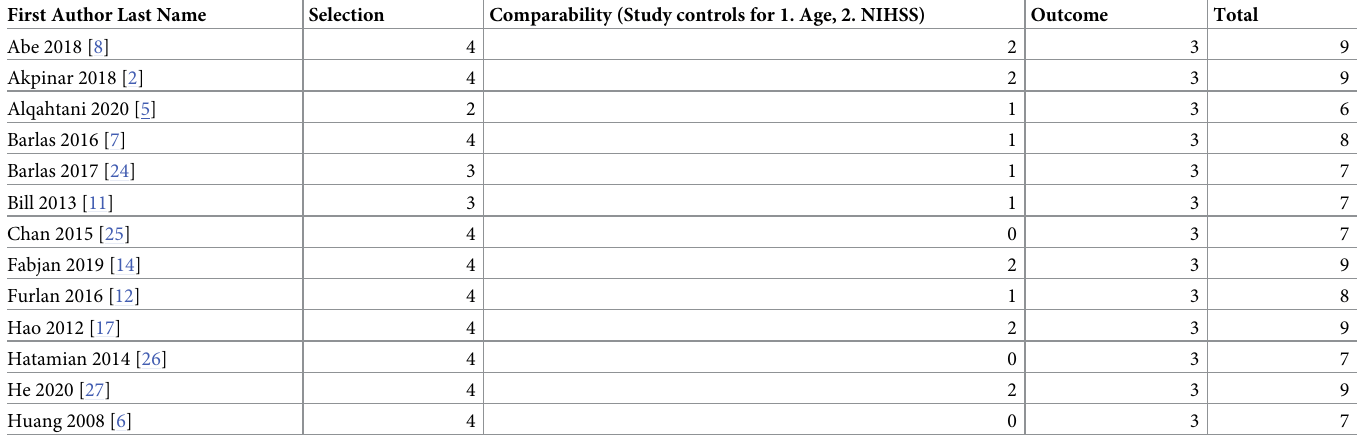
Table 3. Risk of bias